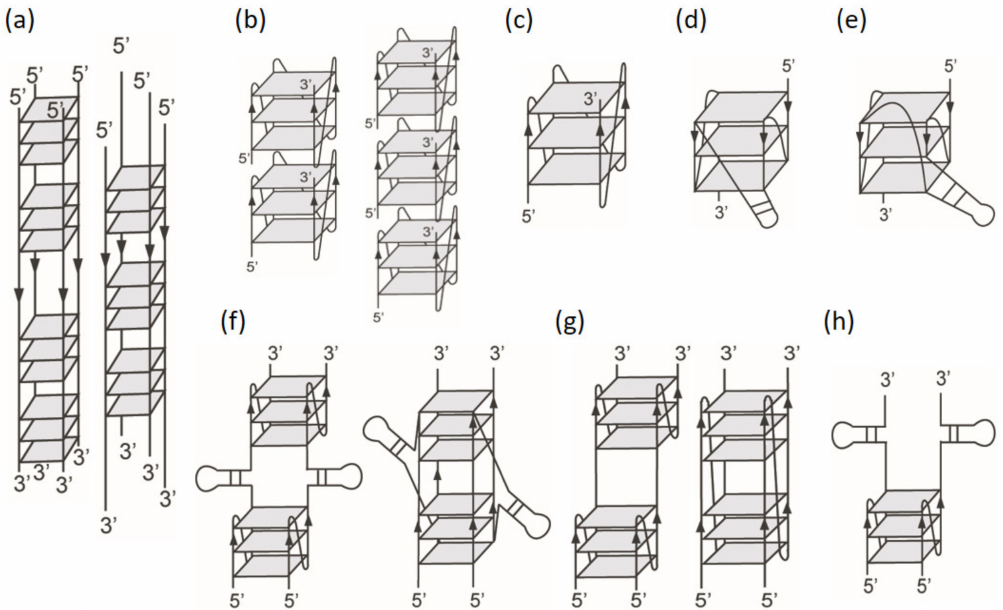
Figure 1. Proposed G4 topologies in this study. ( a ) parallel tetramers, ( b ) stacking of parallel monomers, ( c ) parallel monomer, ( d ) parallel quadruplex-duplex monomer, ( e ) unprecedented quadruplex-duplex monomer, ( f ) parallelquadruplex-duplexdimers, ( g ) parallel quadruplexdimers, ( h )quadruplex-duplex dimer with one